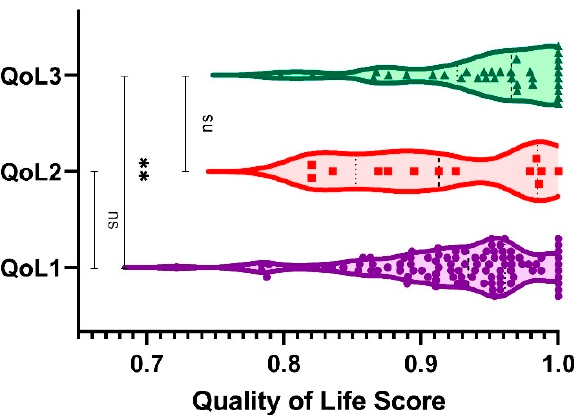
Figure 2. Quality of life comparison between the groups of participants (1 = medical oncology, 2 = radiation oncology, 3 = nurses). **, p -value < 0.01; ns, not